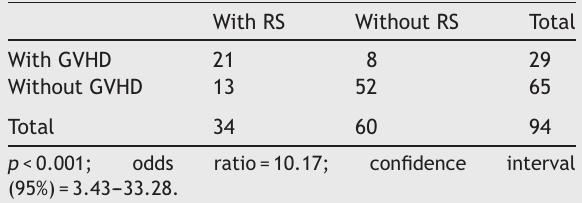
Association of graft vs. host disease (GVHD) with rhinosinusitis (RS).